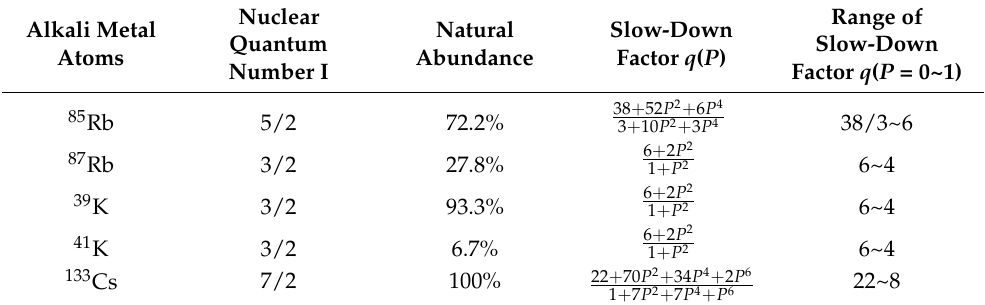
Table 1. Nuclear spin Quantum Number and Slow-down Factor of Alkali Metal Atoms. Alkali